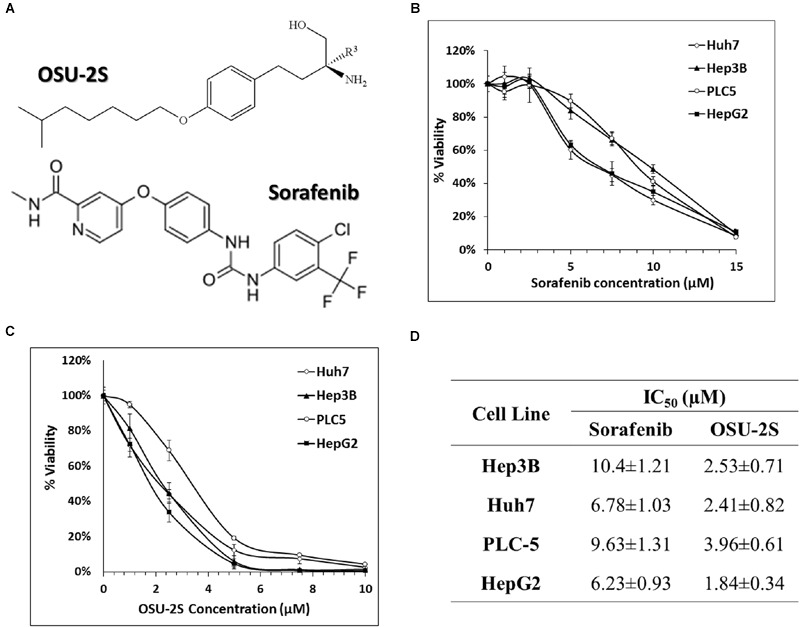
Anti-proliferative effects of sorafenib and OSU-2S in HCC cell lines. (A) Chemical structures of OSU-2S and sorafenib. HCC cells were treated with sorafenib (B) or OSU-2S (C) at the indicated concentrations in 10% FBS-supplemented Dulbecco’s modified Eagle’s medium (DMEM) in 96-well plates for 48 h, and cell viability was assessed by MTT assays. Points, mean; bars, SD (n = 6). (D) The IC50 values of sorafenib and OSU-2S in four HCC cell lines calculated from MTT assays. All data are depicted as mean ± SD (n = 6).